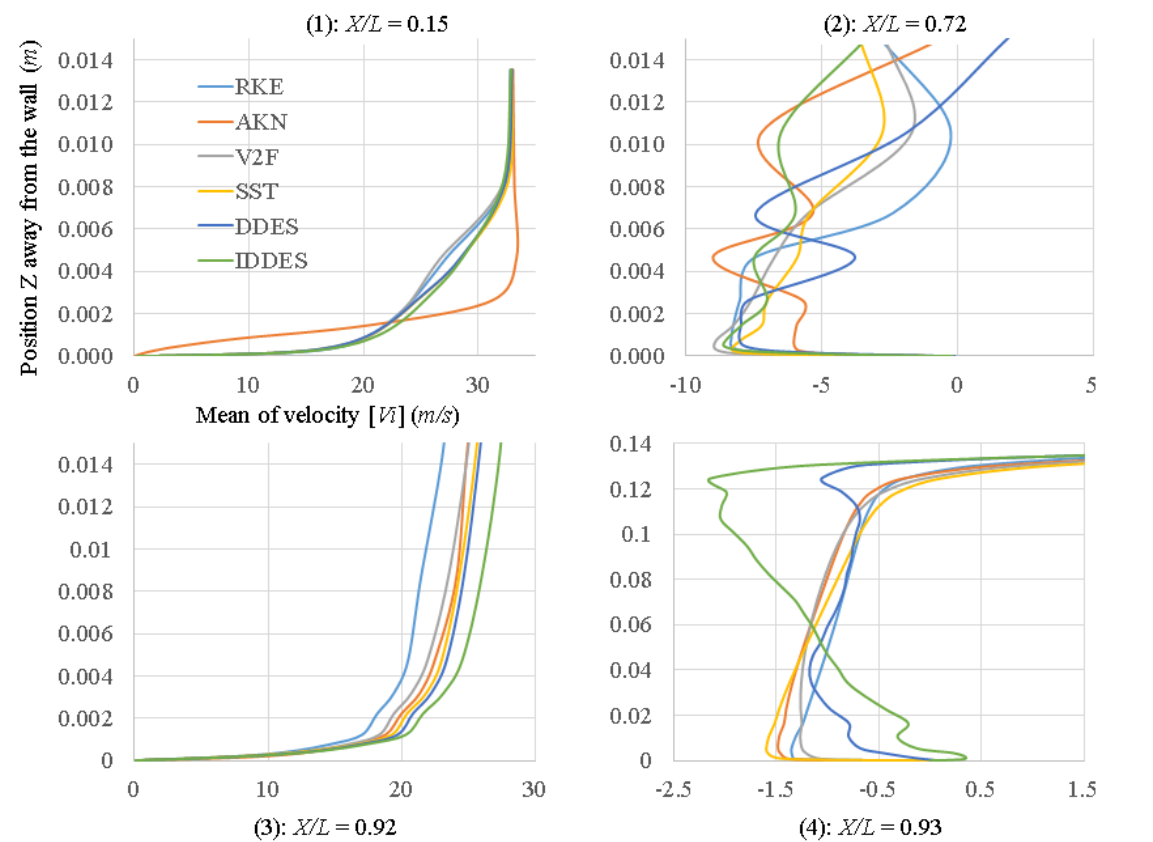
Figure 16. Streamwise velocity profiles for the baseline case at four selected locations on the central plane of the